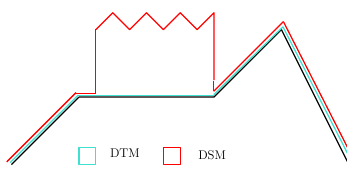
Figure 2: Digital Terrain Model